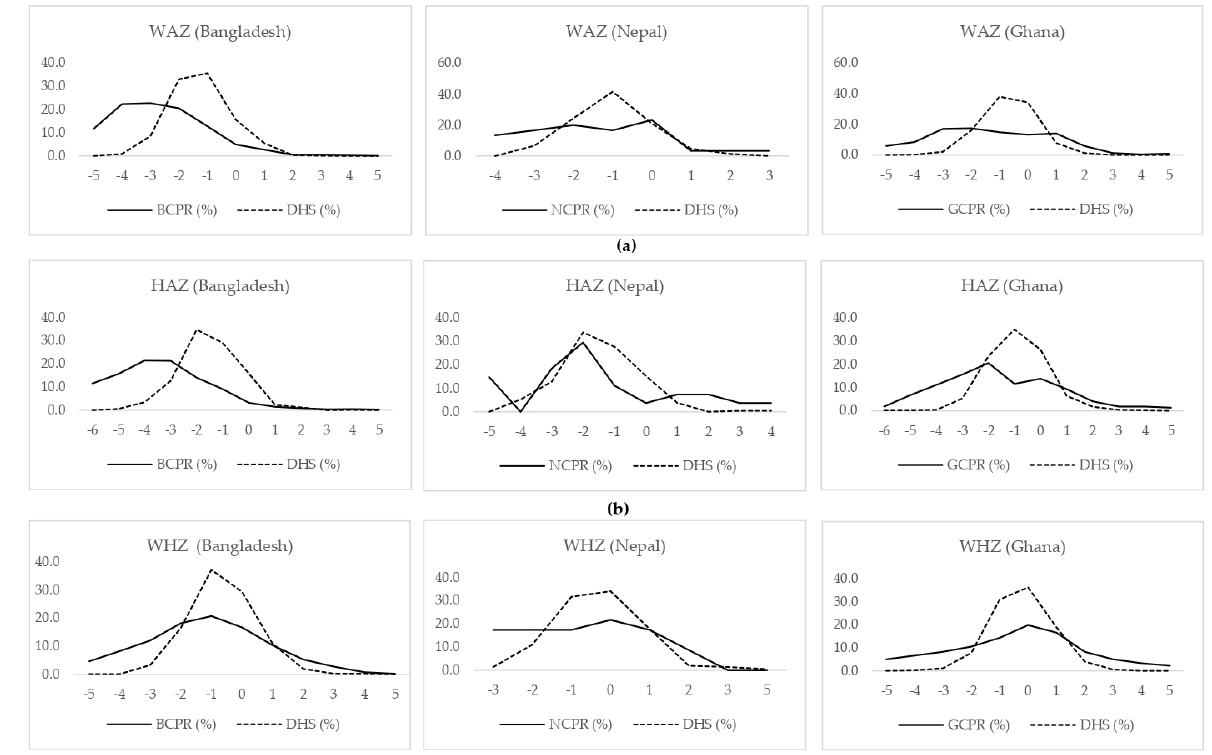
Figure 1. ( a ) WAZ score distribution among children with CP aged ≤ 5 years vs. their peers from the general population in the same region (DHS data were not available for Indonesia). ( b ) HAZ score distribution among children with CP aged ≤ 5 years vs. their peers from the general population in the same region (DHS data were not available for Indonesia). ( c ) WHZ score distribution among children with CP aged ≤ 5 years vs. their peers from the general population in the same region (DHS data were not available for Indonesia).